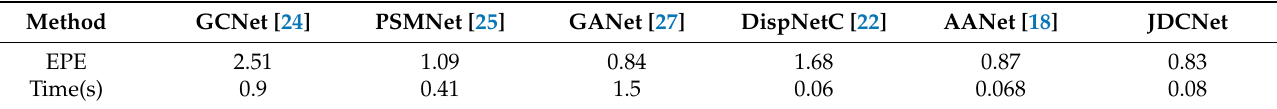
Table 2. Performance comparison on Scene Flow test set. GCNet, PSMNet, GANet are all 3D stereo networks, while DispNetC and AANet are fast stereo networks. AANet is recent proposed fast and accurate stereo method. Our method is more accurate than other fast (2D) and accurate (3D) stereo methods, also with fast